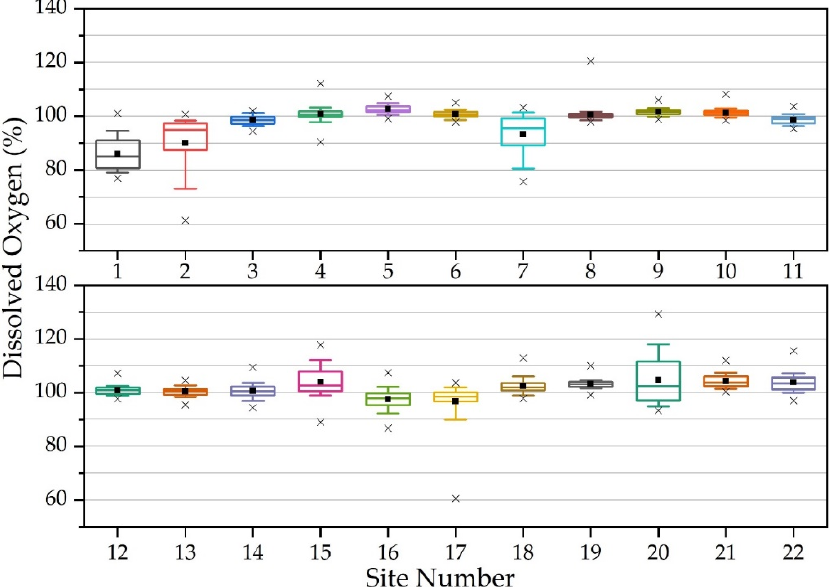
Figure 7. Box and whisker plot of dissolved oxygen (%) descriptive statistics at 22 sampling locations during study period (2 January 2018–1 January 2019) in West Run Watershed, Morgantown, WV, USA. Box delineates 25th and 75th percentiles; line denotes median; square shows mean; whisker describes 10th and 90th percentiles; x shows maximum and minimum when above and below, respectively.